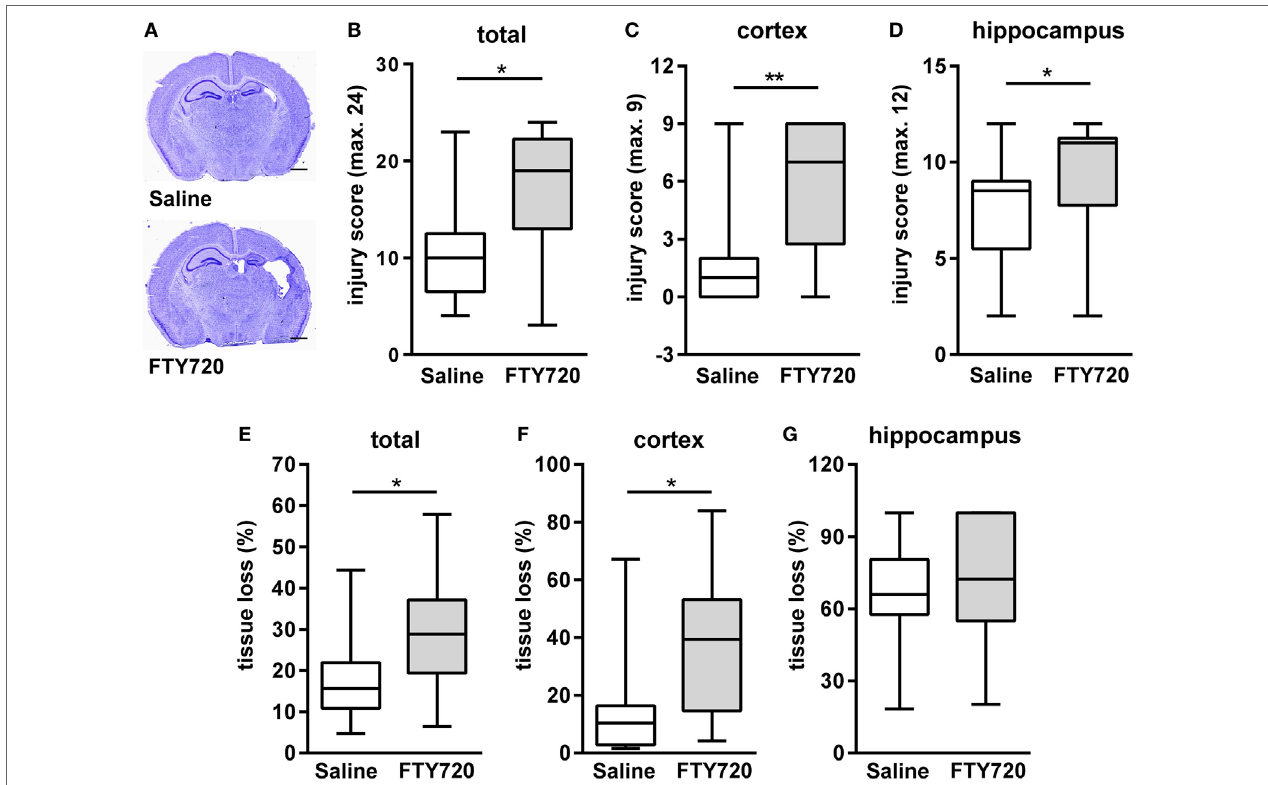
FigUre 2 | FTY720 treatment exacerbates brain injury 1 week after neonatal HI. Histological brain injury was determined on cresyl violet stained 20 µm cryostat sections of P16 mice that were exposed to HI followed by a single intraperitoneal injection of 1 mg/kg FTY720 or 0.9% NaCl (saline) on P9. (a) Representative images of brain sections ( − 1.9 to − 2.0 mm from bregma) for each experimental group are shown (scale bar: 1 mm). (B) Injury scores were assessed in different brain regions, e.g., cortex (c) and hippocampus (D) according to a previously described scoring system in eight regions. Each region was given a rating from 0 to 3 (0—no detectable cell loss, 1—small focal areas of neuronal cell loss, 2—columnar damage in the cortex or moderate to severe cell loss in the other regions, 3—cystic infarction and gliosis). The sum score from different regions (cortex, hippocampus, and striatum) was calculated for each animal resulting in a total maximum score of 24. (e–g) Brain atrophy was assessed at the level of the striatum ( + 0.2 to + 0.3 mm from bregma) and hippocampus ( − 1.9 to − 2.0 mm from bregma) in two consecutive sections per region and animal by measurement of intact areas in ipsilateral and contralateral hemispheres using Image J. Tissue loss was determined by comparison with contralateral values. Overall and local cortical tissue injury was significantly increased by FTY720 treatment. n = 14–16/group, * p < 0.05, ** p < 0.01, Mann–Whitney